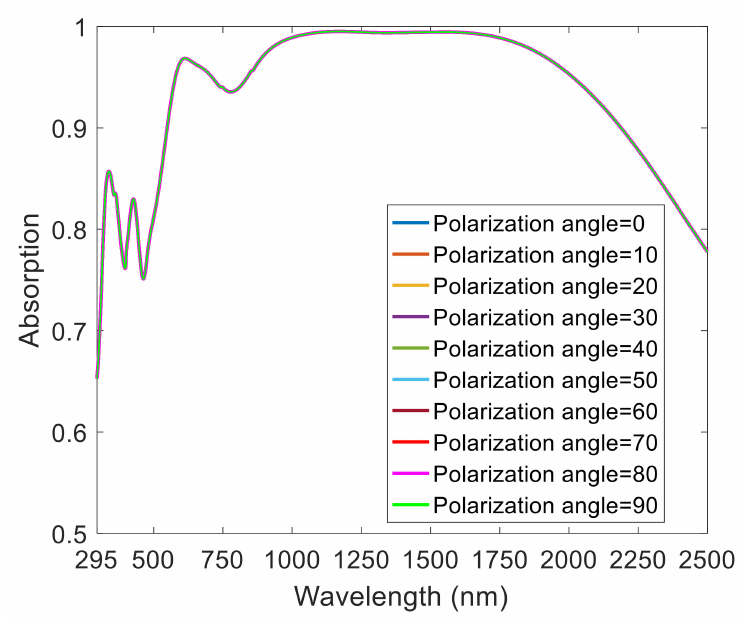
Figure 3. Normalized absorption spectrum of absorber with a polarization angle increasing from 0 to 90 ◦ (TE polarization to TM polarization) at normal incidence.